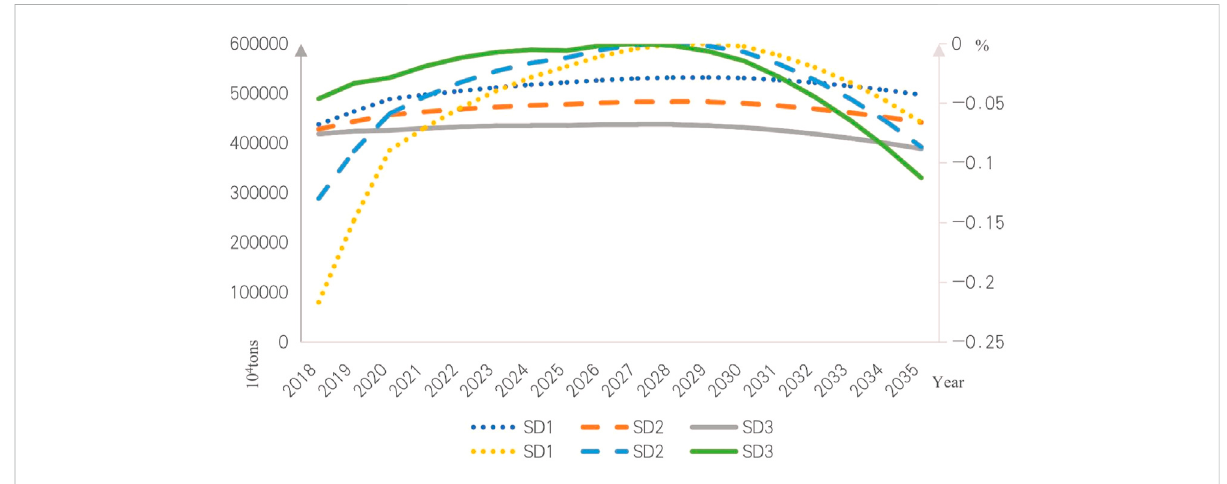
FIGURE 6 Gap between China ’ s coal consumption and peak value under the enhanced development scenario from 2018 to